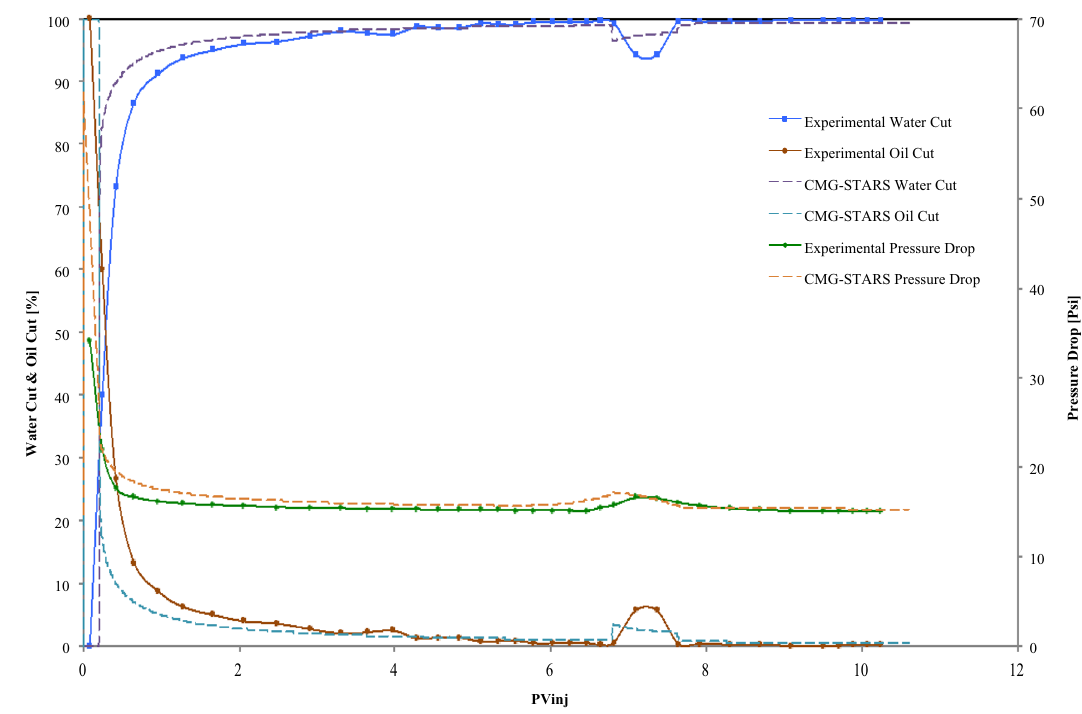
Fig. 13 History matching of the experimental and simulation water cut, oil cut, and pressure drop for Alkaline (0.7 wt% Na